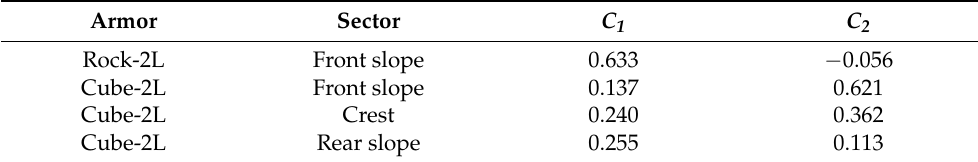
Table 1. Value of coefficients C 1 and C 2 for Equation (11) given by